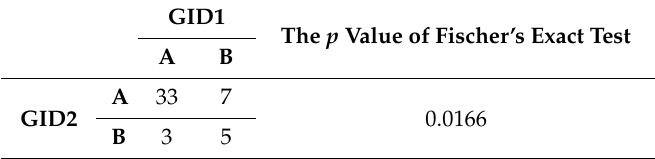
Table 5. Joint finding of RHT-1, GID1, and GID2 protein isoforms in Ae. tauschii accessions. RHT-1 The p Value of Fischer’s Exact Test * A B C D GID1 0.0001 B GID2 0